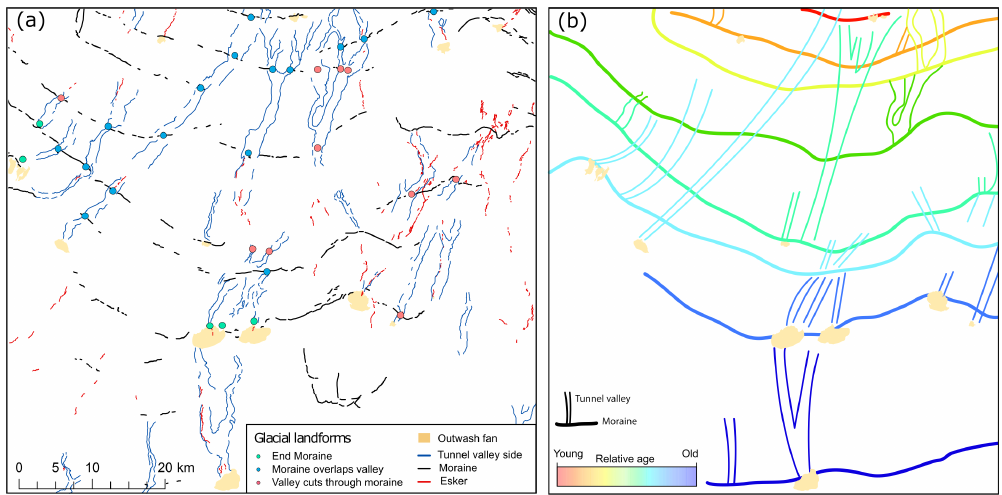
Figure 16. Using cross-cutting relationships to reconstruct tunnel valley evolution during ice margin retreat. (a) Mapping of tunnel valleys and associated glacial bedforms in Wisconsin (Chippewa Lobe) (from Fig. 11b). (b) Reconstructed history of valley formation behind a back-stepping ice margin. Note that some valleys were long-lived during deglaciation and some abandoned shortly after their formation. The relative age relations help explain the variation in lengths between long continuous tunnel valleys and those comprising short